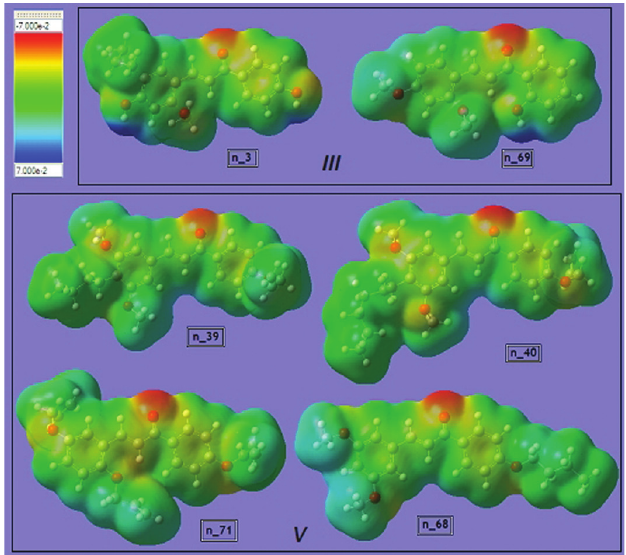
FIGURE 7 - Electrostatic potential maps calculated on the Connolly surfaces of the chalcone derivatives from sub- clusters III and V . Negative electrostatic potential regions are represented in red (high electronic density) while positive electrostatic potential areas are shown in dark blue (low electronic density).